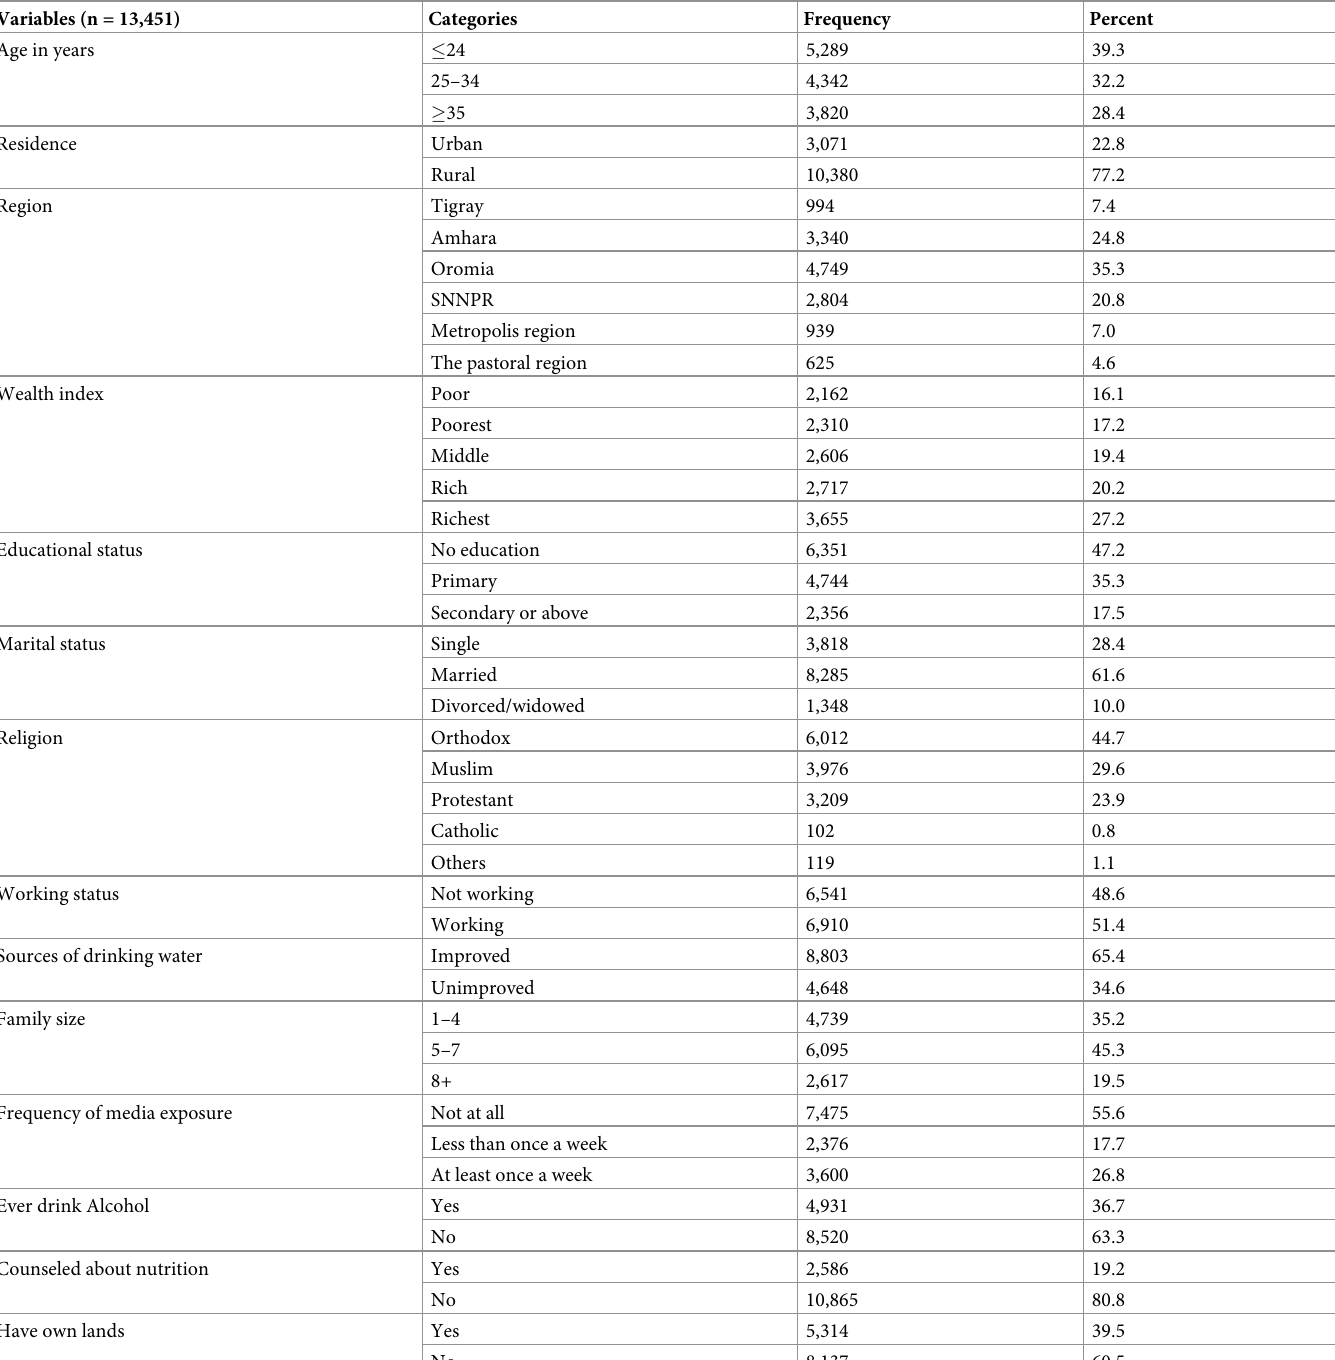
Table 1. Characteristics of non-pregnant reproductive-age women in Ethiopia; 2016